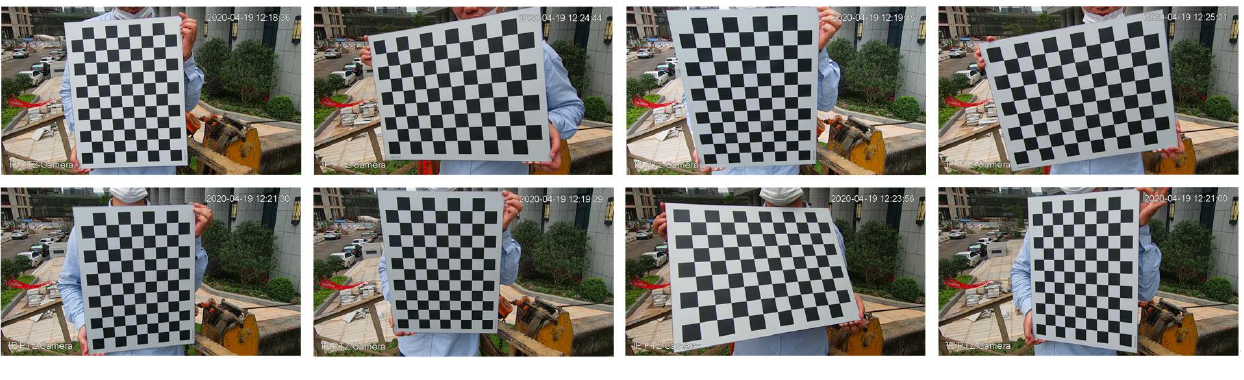
Figure 5. Eight images of the chessboard.